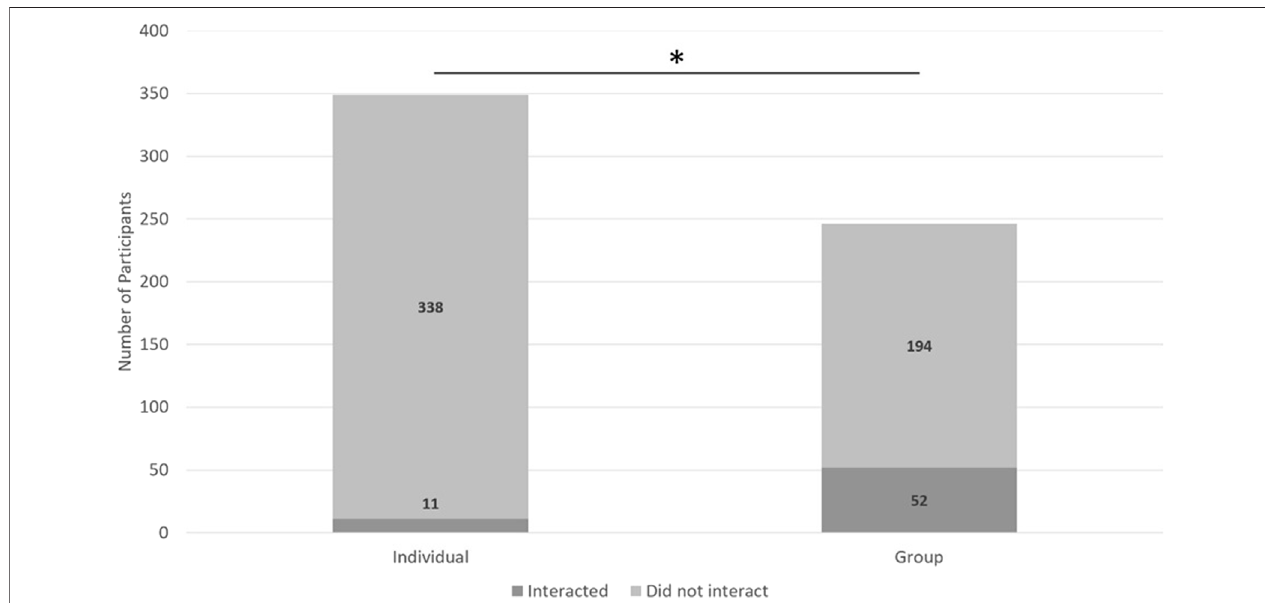
FIGURE 1 | A description of the results from H1a. Asterisks indicate groups were more likely to verbally interact than individuals.